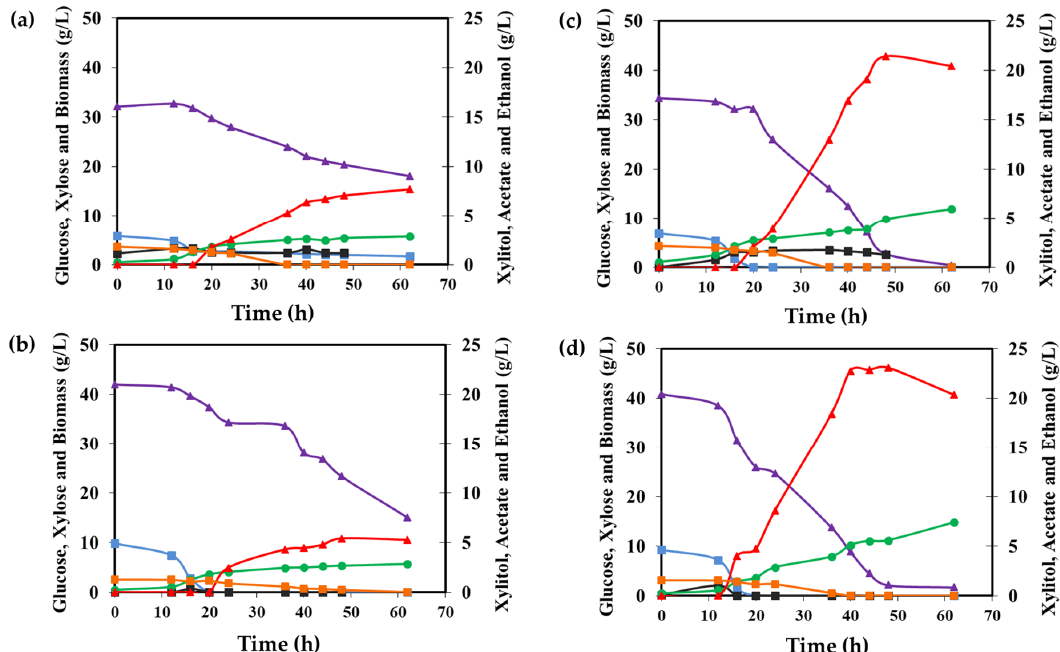
Figure 5. Xylitol production in sugarcane bagasse hydrolysate in a bench bioreactor. ( a ) M. guilliermondii A3, ( b ) M. guilliermondii B12, ( c ) Spathaspora sp. JA1, and ( d ) W. anomalus 740. Xylose (purple line), xylitol (red line), glucose (orange line), ethanol (black line), acetate (blue line), and biomass (green line). Experiments were performed in duplicate and one replicate is